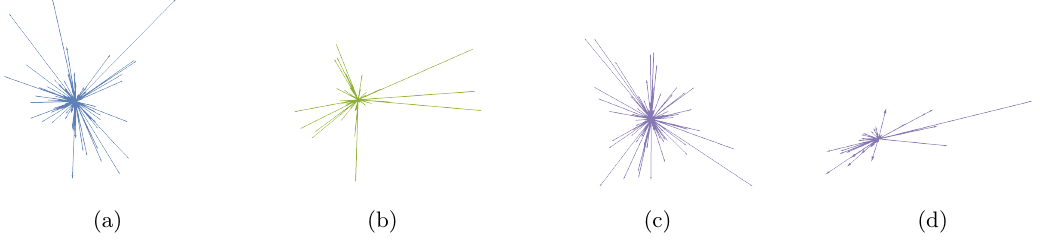
Figure 10 . Visualizations of a characteristic final state radiation pattern for the (a) ν 1 = 2 , (b) ν 1 = 3 , (c,d) ν 1 = 4 and ν 2 = ν 3 = 0 samples. The chosen events for ν 1 = { 2 , 3 } have event isotropy that are equal to the mean value of the distributions: (a) hI sph i = 0 . 44 and (b) hI sph i = 0 . 54 . We 192 192 show two events for the ν = 4 sample, selected from the peaks of the bimodal distribution in event 1 isotropy: (c) hI sph i = 0 . 31 and (d) hI sph i = 0 . 69 . All momenta in the event are plotted, with the 192 192 length proportional to the